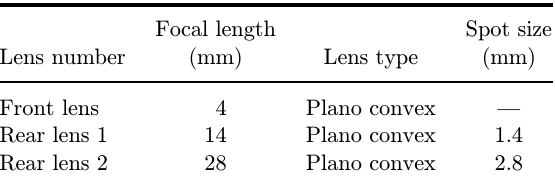
Table 1. Lens focal length